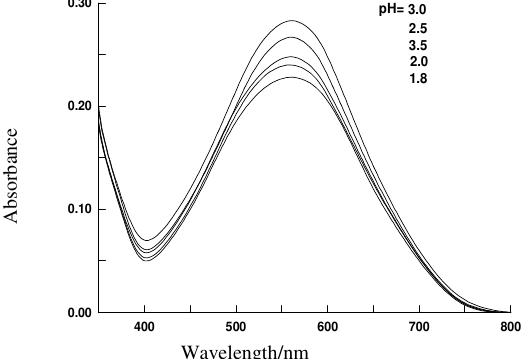
Figure 1 . Effect of pH on complex formation at the conditions in which the concentration of Fe(III) and 2,6-DHB were equal to 1.5 × 10 -4 M, and the absorbance measurements were carried out at 560 nm as the maximum wavelength.